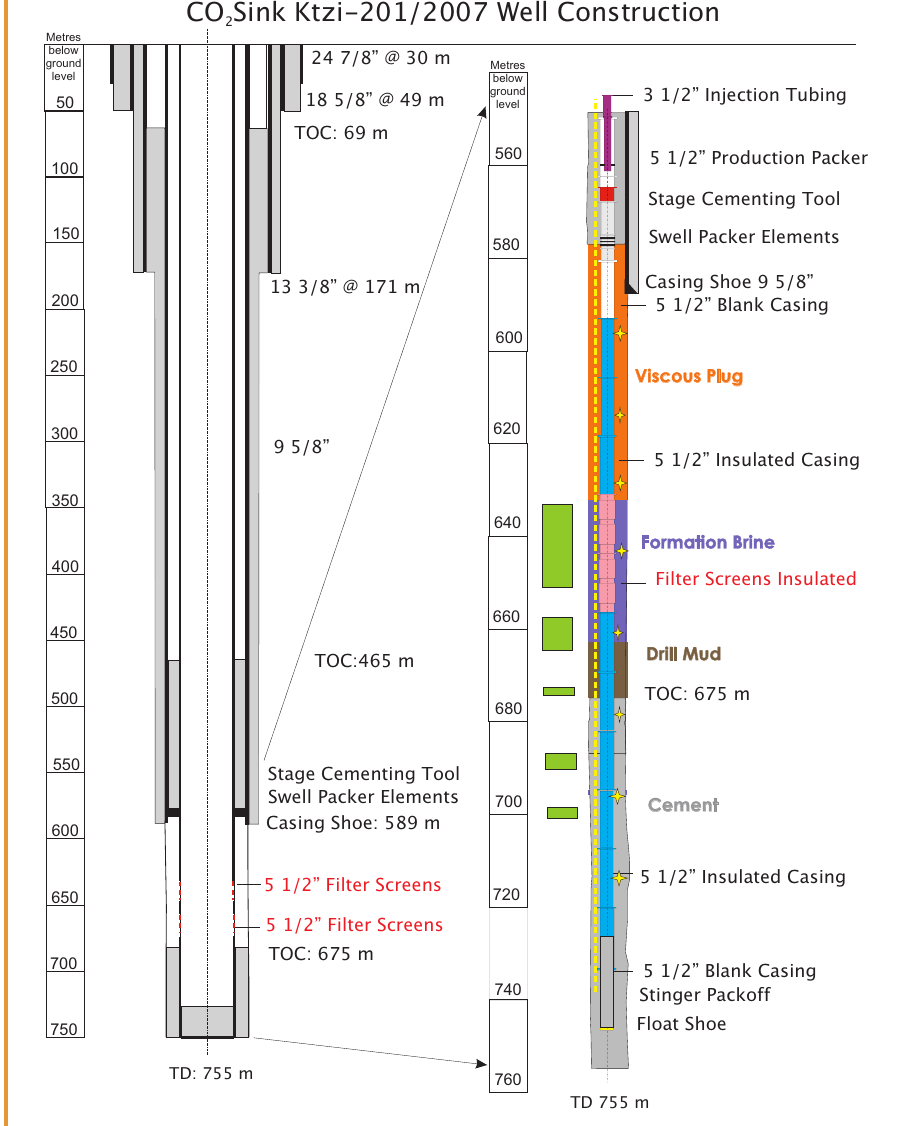
Figure 4. Drilling design and well completion of the Ktzi 201/2007 borehole. Yellow line indicates DTS and ERT cables with location of ERT electrodes (yellow pluses). Sandstone reservoir intervals are shown in